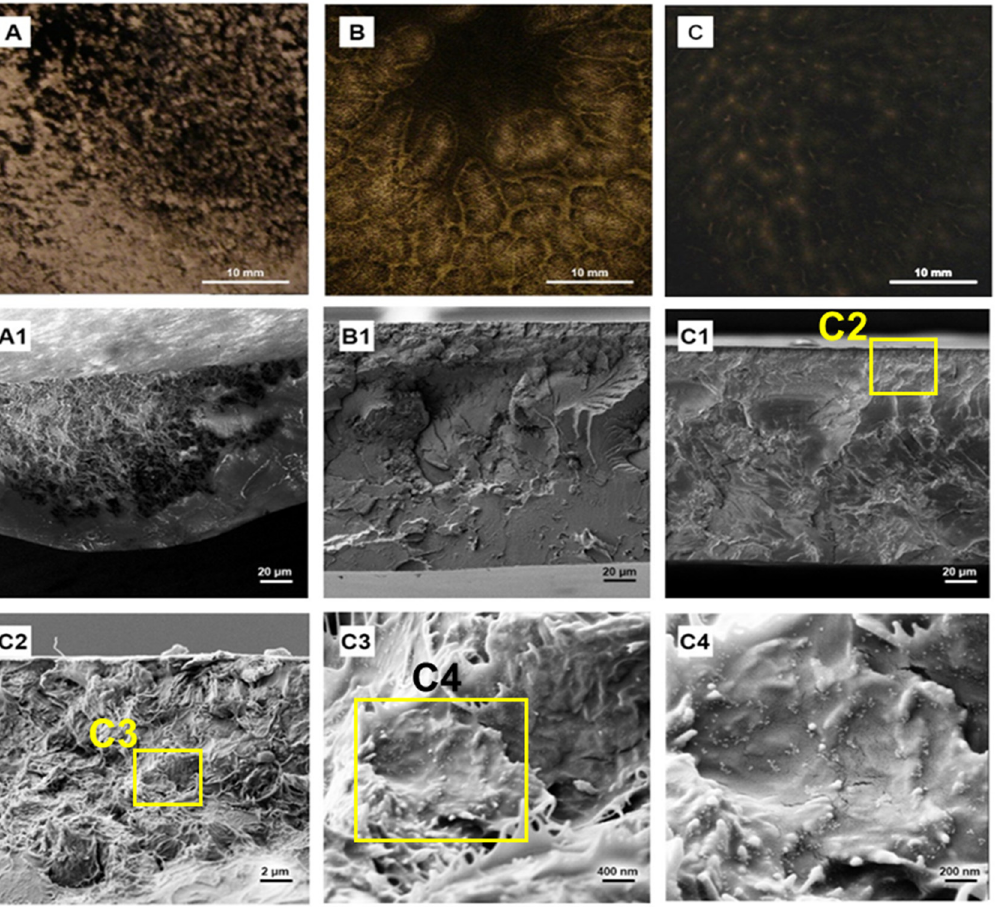
Figure 10. Digital photos of PVC/1% GN, PVC/1%GN–CU and PVC/1% GN–CE ( A – C ), SEM images of those materials ( A1 , B1 , C1 ) and zoomed in structure of PVC/1%GN–CE ( C2 – C4